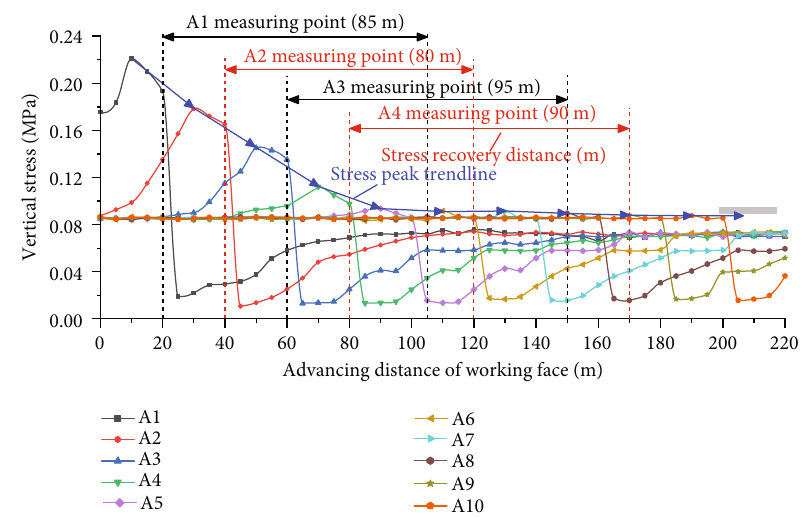
Figure 9: Transfer characteristics of fl oor stress during mining of the no. 7-1 coal seam.